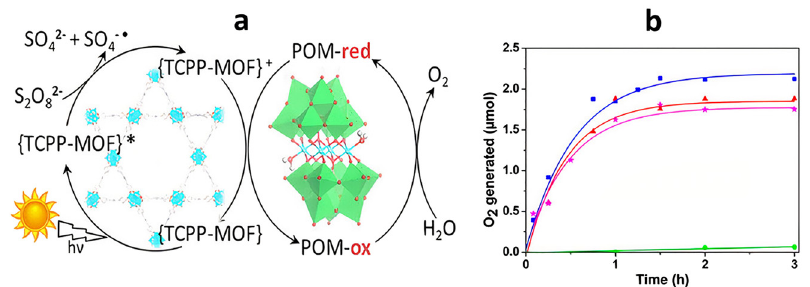
Figure 8: Schematic illustration of proposed light-induced OER mechanism by P 2 W 18 Co 4 @MOF-545 POMOF. (b) Kinetics of light-driven O 2 evolution (blue)